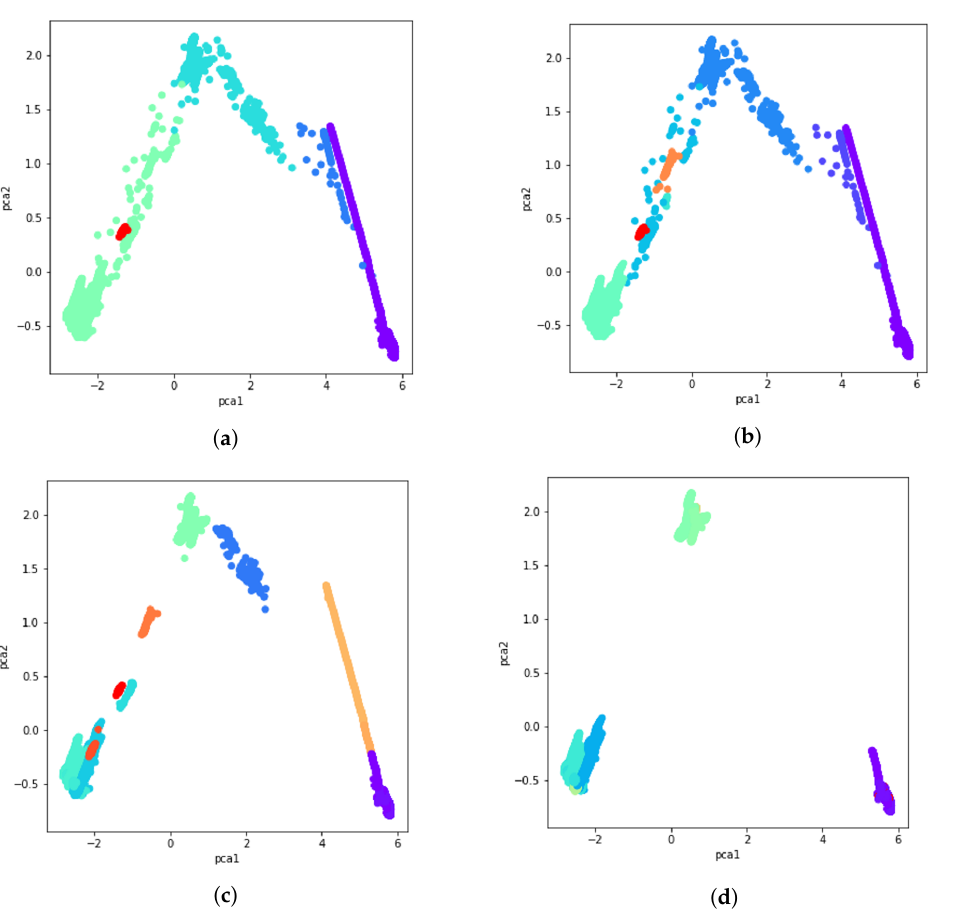
Figure 13. Following the filtering process, the PCA visualization of cluster ensembles with different cluster consistency is shown. ( a ) With 80% consistency of clusters. ( b ) With 85% consistency of clusters. ( c ) With 94% consistency of clusters. ( d ) With 98% consistency of